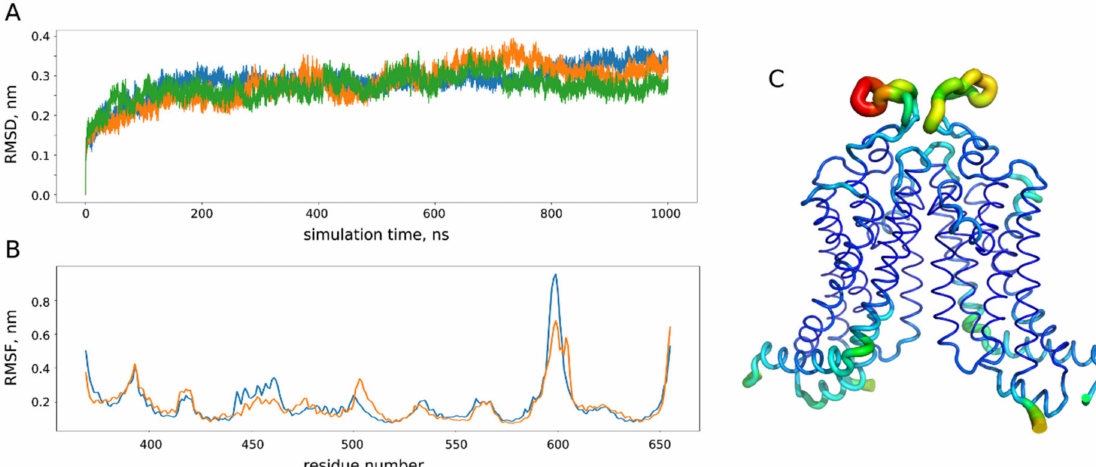
Figure 8. Analysis of molecular dynamics (MD) trajectories for the ABCG2 model. ( A ) Root mean square deviation (RMSD) of the protein backbone atom from the initial crystal structure (PDB ID: 6eti) in three replicates (blue, orange and green) of microsecond MD simulations. ( B ) Root mean square fluctuations (RMSF) of the protein backbone in three simulations (orange and blue correspond to different chains of a dimer). ( C ) RMSF projection on the protein structure: the most flexible parts are shown in yellow and red. During the simulations, we did not observe any pronounced conformational changes with the root mean square deviation from the initial experimental structure reaching approximately 3 nm after 100 ns of simulation, which is in accordance with 200 ns MD studies performed for ABCG2 homology models [22]. The most flexible part according to analysis of the protein backbone fluctuations corresponds to the extracellular loops (residues 580–610 in ( B , C )), while the rest of the protein structure remains quite